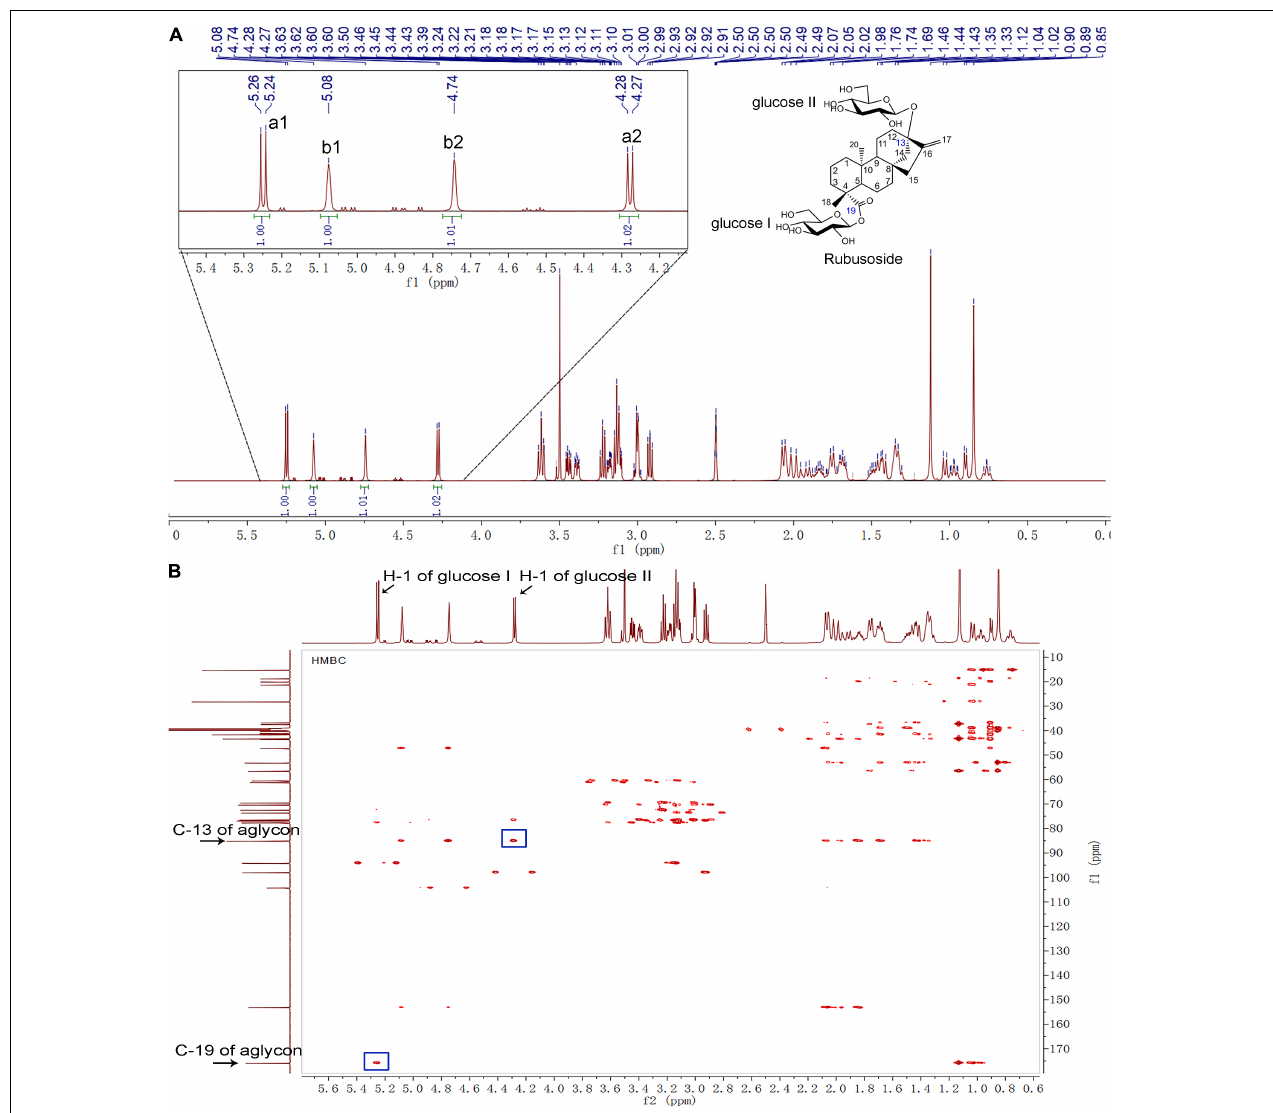
FIGURE 7 | NMR analysis of the hydrolysis production from stevioside by Cs BGL. ( δ : ppm) (A) 1 H-NMR 600 MHz spectrum. The four peaks in the anomeric region (4.2–5.3 ppm) were labeled as a1, b1, b2, and a2, from low to high field. (B) HMBC NMR spectrum. The H-1 of glucose I/II, C-13/19 of aglycon, and their cross peaks were